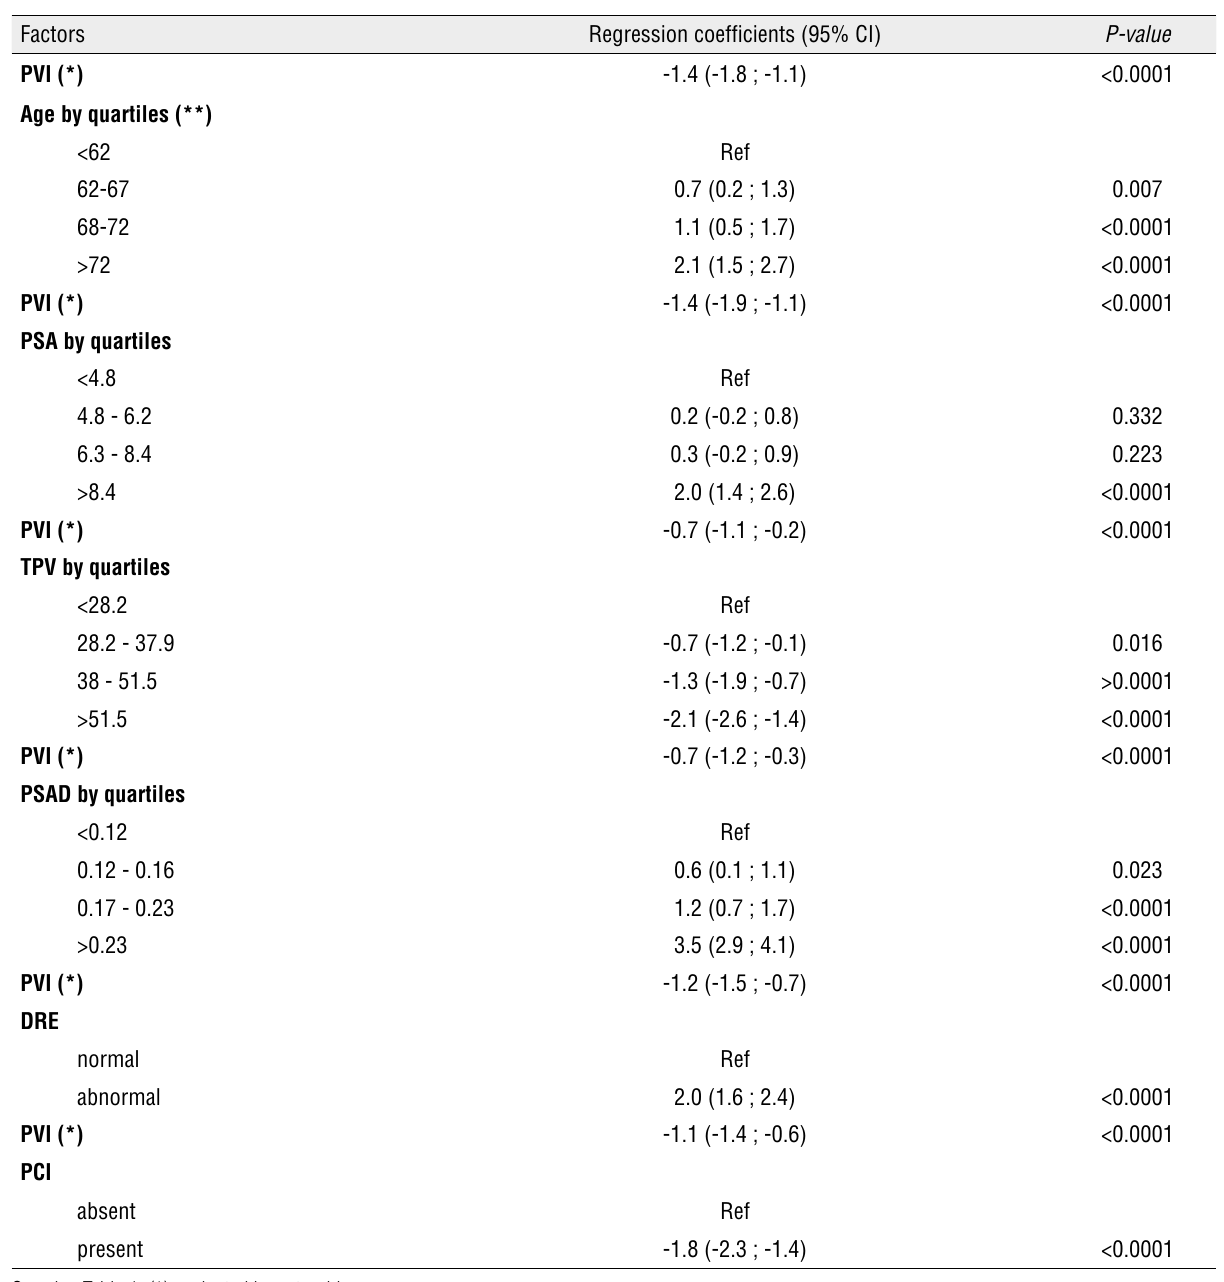
Table 3 - Bivariate linear regression models of factors predicting the number of positive